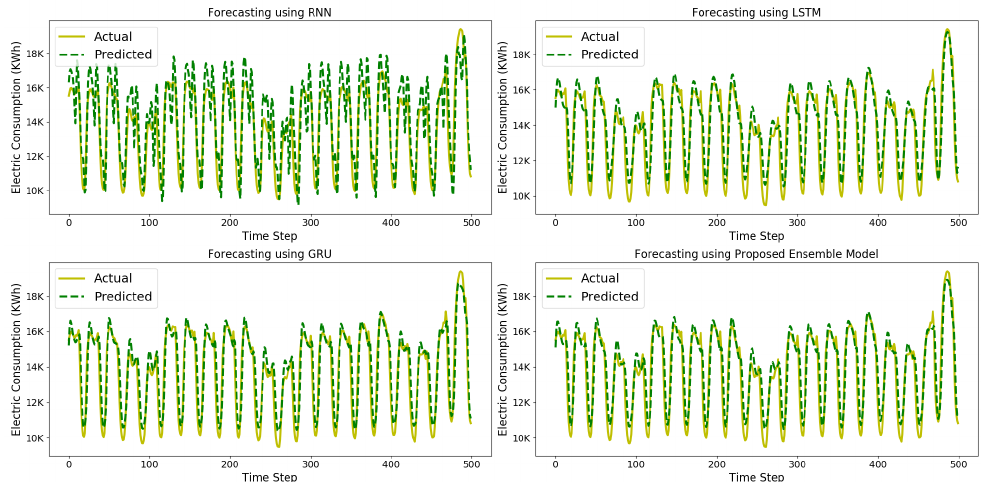
Figure 10. Electricconsumption forecasting using proposed ensemble and conventional time- series models.